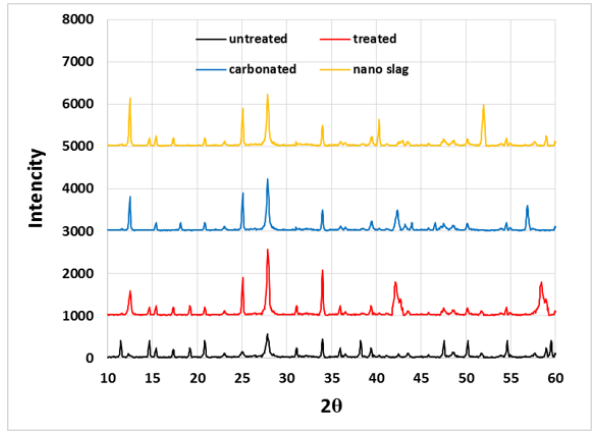
Figure 8: X-ray diffractions for: (a: untreated), (b: treated), (c: car- bonated) and (d: with nano